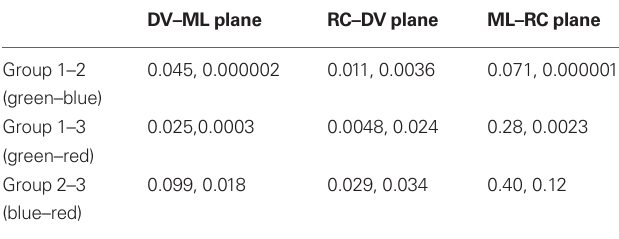
Table 2 | Significance levels for 2D K–S test applied on types of points as defined by the K-means test (Monkeys H,